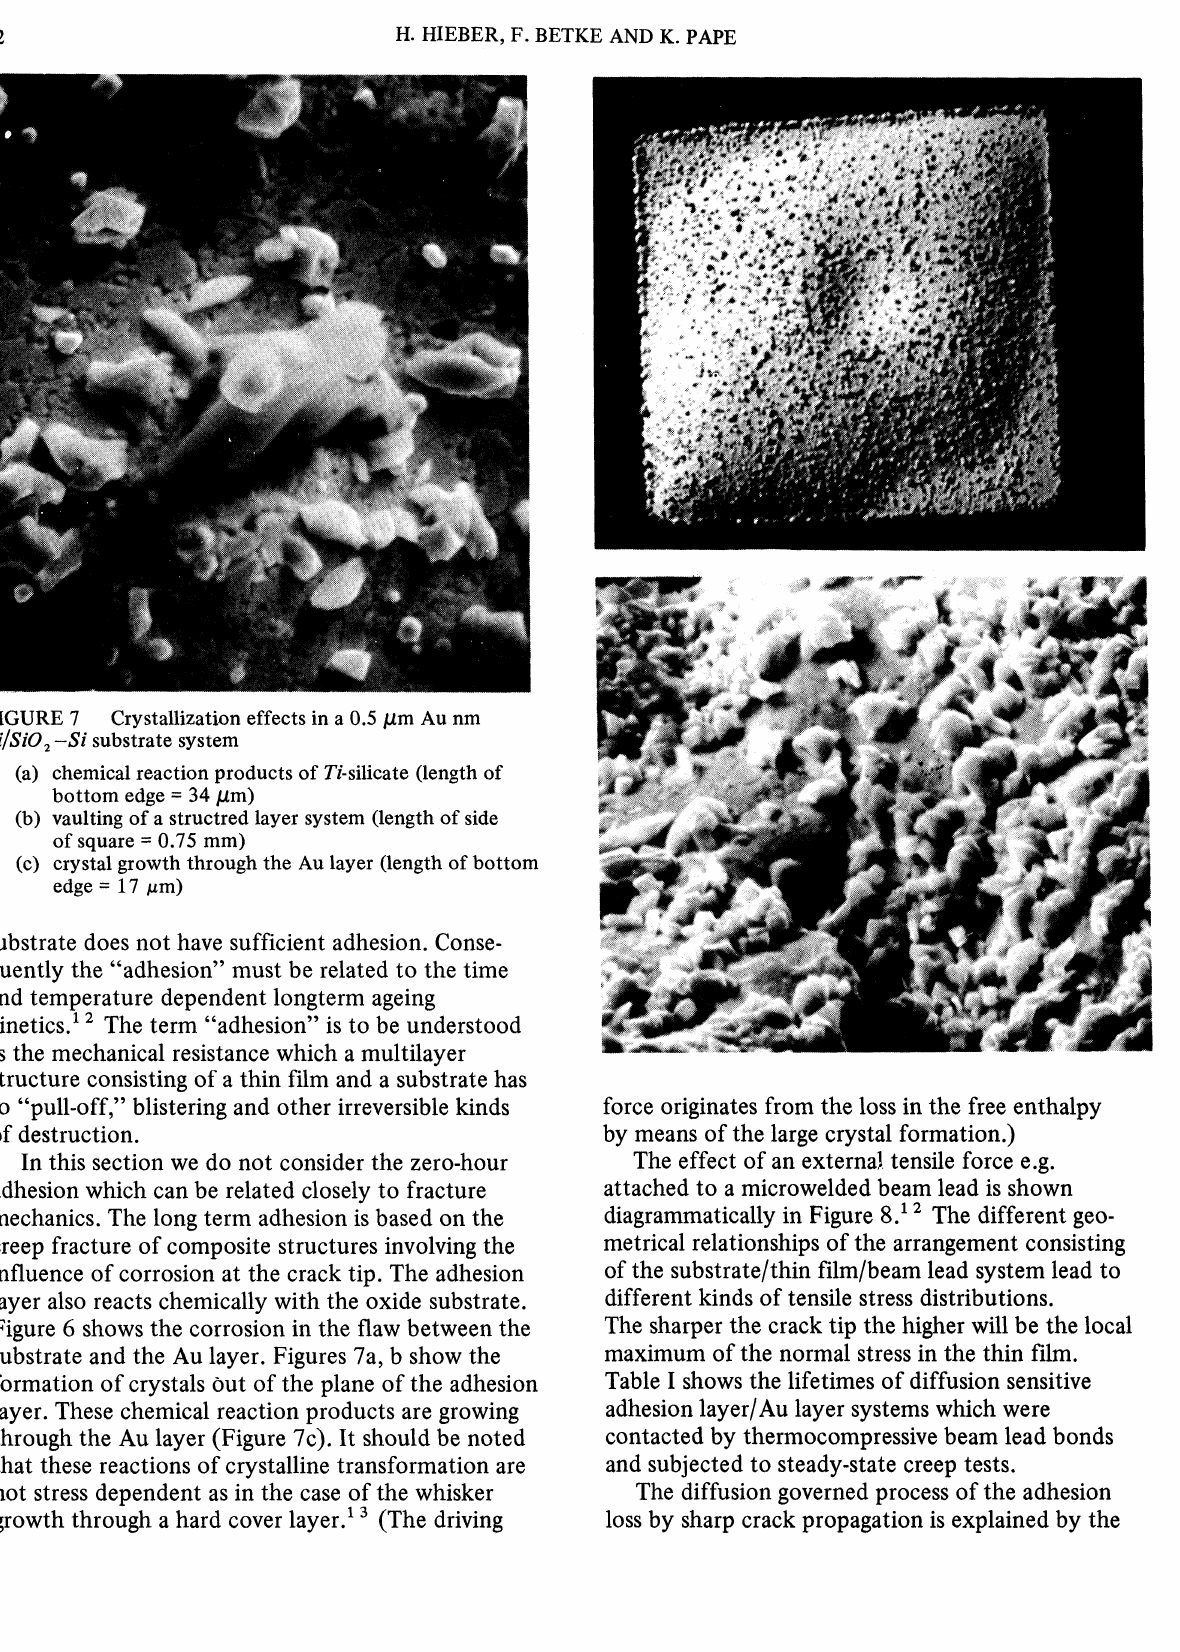
Crystallization effects in a 0.5/am Au nm Ti/SiO:-Si substrate system (a) chemical reaction products of Ti-silicate (length of bottom edge 34/am) (b) vaulting of a structred layer system (length of side of square 0.75 mm) (c) crystal growth through the Au layer (length of bottom edge 17